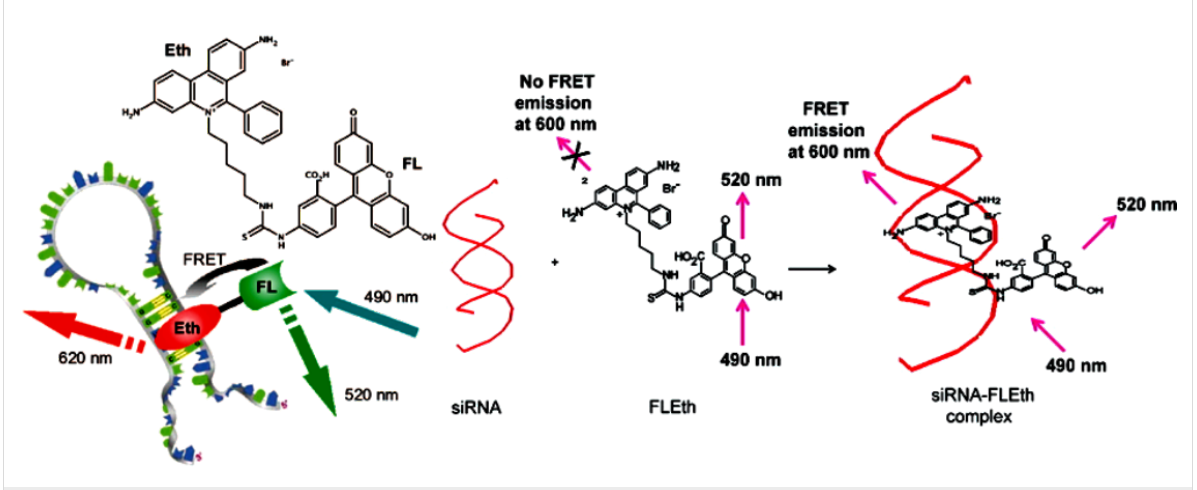
Figure 8: Two-colour RNA intercalating probe for cell imaging applications: Left: Chemical structure of EB-fluorescein conjugate ( FLEth ) and cartoon depicting the energy transfer process from fluorescein to the intercalated phenanthridine fluorophore. Reproduced with permission from [83]. Copy- right 2008 American Chemical Society.; Right: Convenient Reporter for Small Interfering RNAs fluorophore. Reproduced with permission from [84]. Copyright 2009 American Chemical Society.